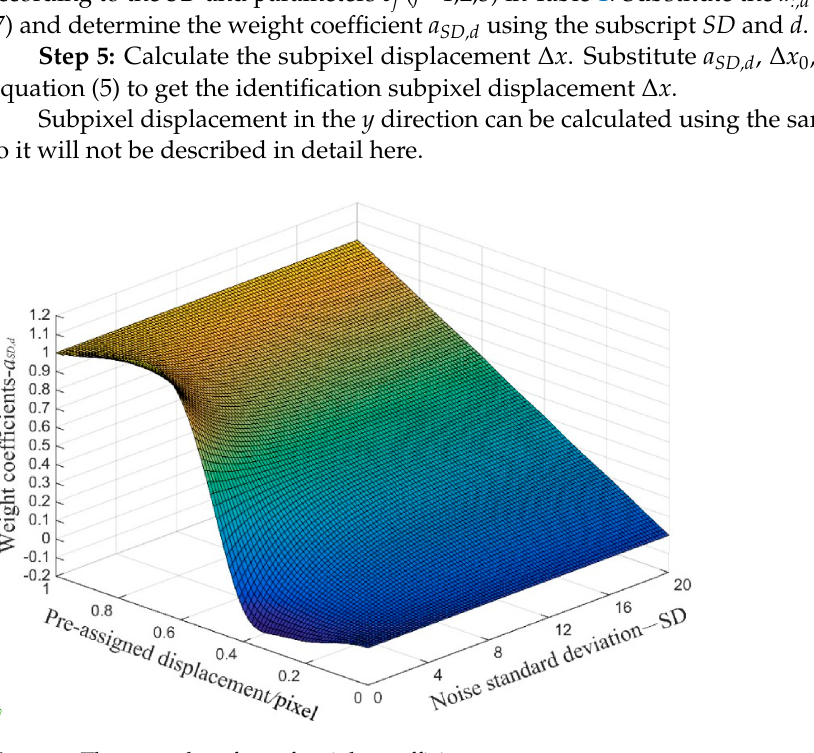
Table 1. Coefficient for a :,d .